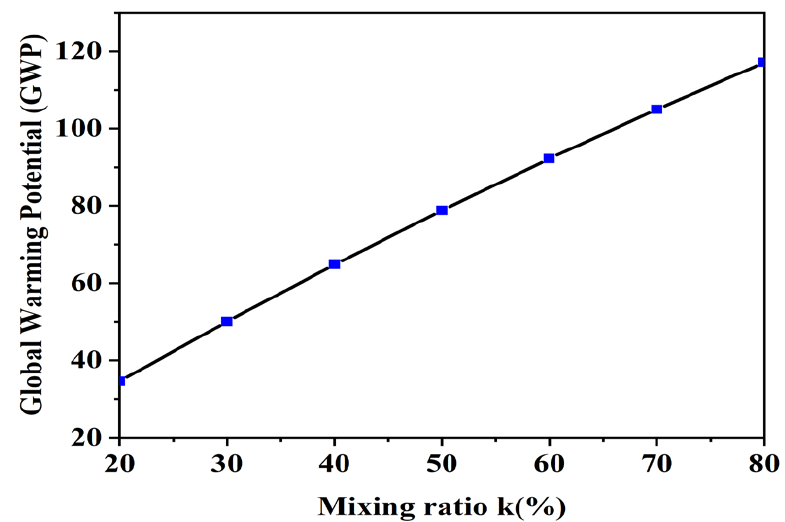
Figure 7. Global Warming GWP analysis of R152a/CO 2 gas mixture.